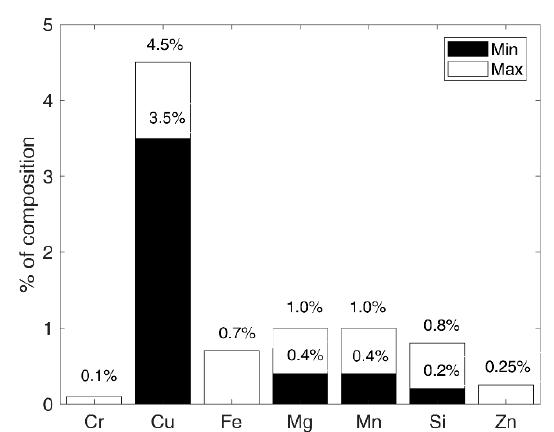
Figure 1. Chemical composition of the test material according to EN 573-3 standard.